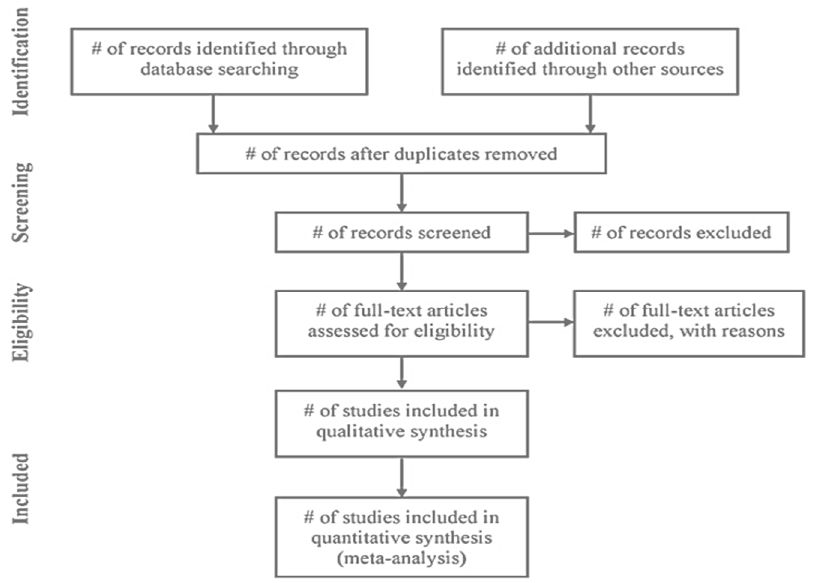
Figure 2. PRIMSA framework of literature search and review. Source: [34].